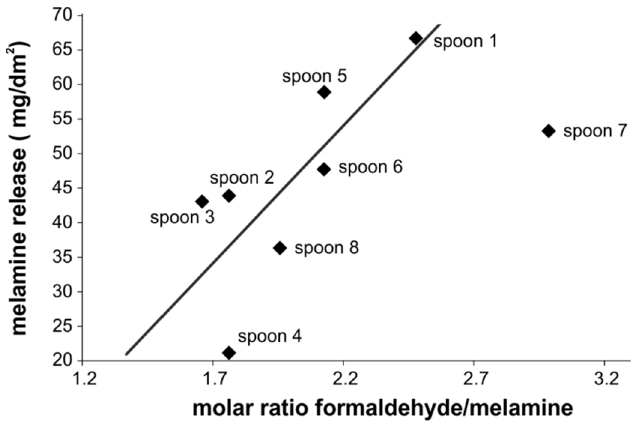
Figure 7. Dependence of melamine release of the molar ratio of formaldehyde to melamine (formaldehyde results corrected by a factor of 1.4, results from the 3rd release test); spoon 7 is treated as an outlier.